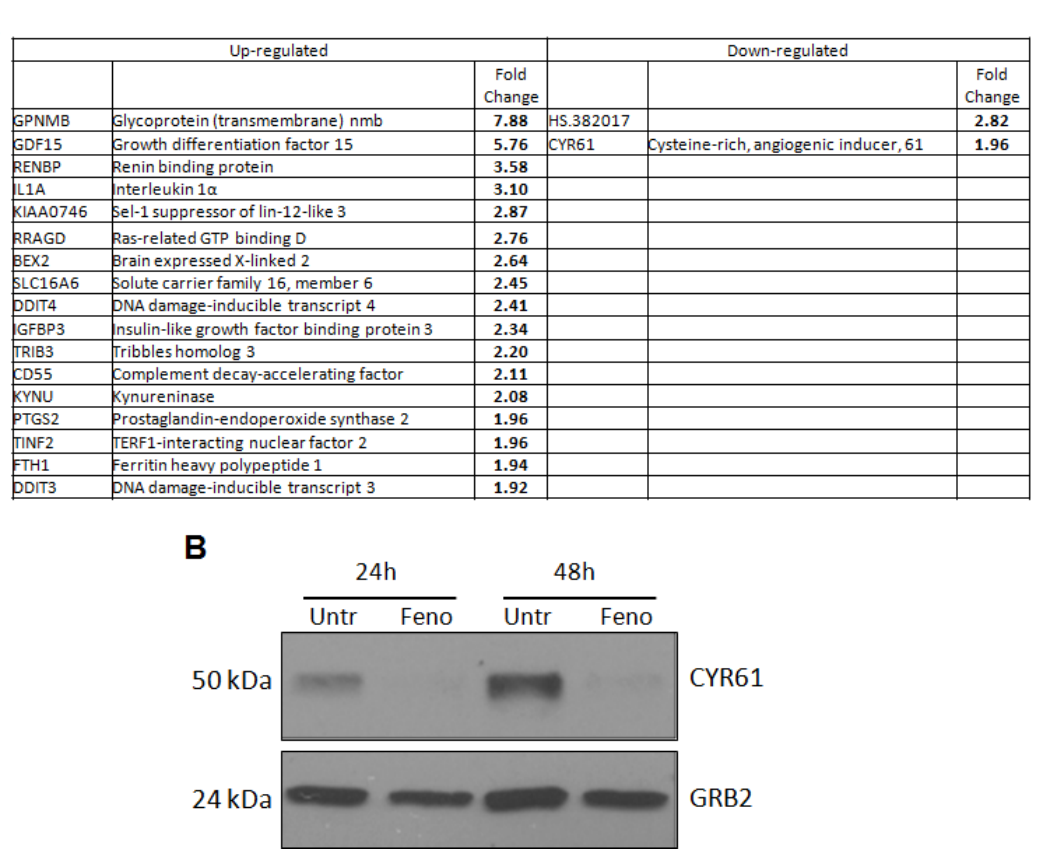
Figure 5. (A) List of fenofibrate regulated mRNAs in LN229 cells. Fold change values reflect mRNA levels in cells treated with 50 µM fenofibrate versus untreated cells. Results shown are the average of two independent experiments. ( B) Down-regulation of CYR61 protein expression in LN229 glioblastoma cells after fenofibrate treatment. Western blot of CYR61 was performed on lysates from cells that were untreated or treated with fenofibrate (50 µM) for 24 h or 48 h. GRB2 antibody was used to show equal loading of cellular lysates.